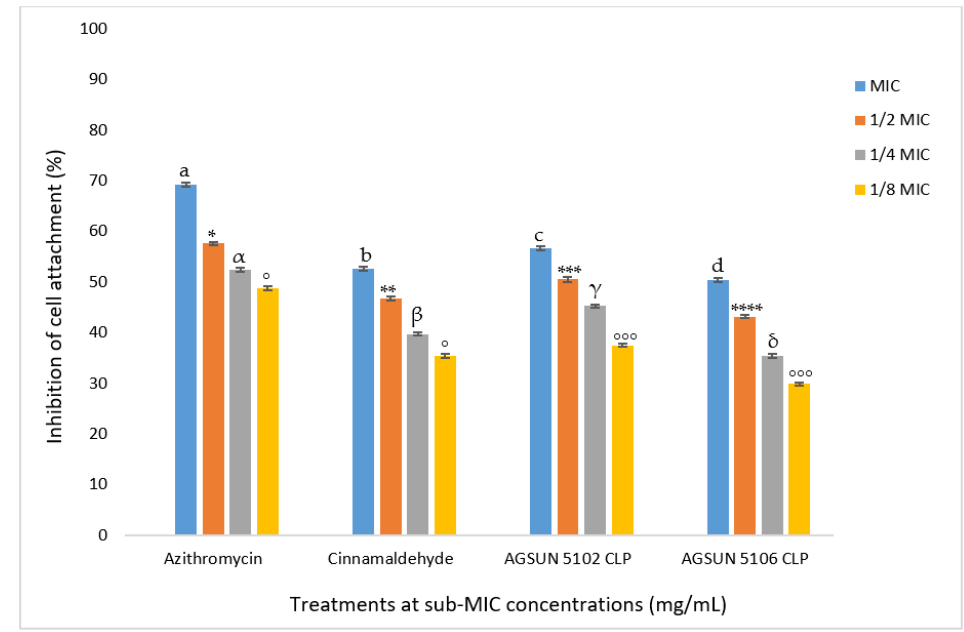
Figure 4. Inhibitory effect of the essential oils on cell attachment of P. aeruginosa ATCC 27853 at sub-MIC concentrations (mg/mL) of azithromycin at 0.25–0.031 mg/mL (MIC to 1/8 MIC), cinnamaldehyde at 3.75–0.47 mg/mL (MIC to 1/8 MIC), and both oils (AGSUN 5102 CLP and AGSUN 5106 CLP) at 91.8–11.48 mg/mL (MIC to 1/8 MIC). Letters/symbols represent statistical differences at p -value ≤ 0.05.